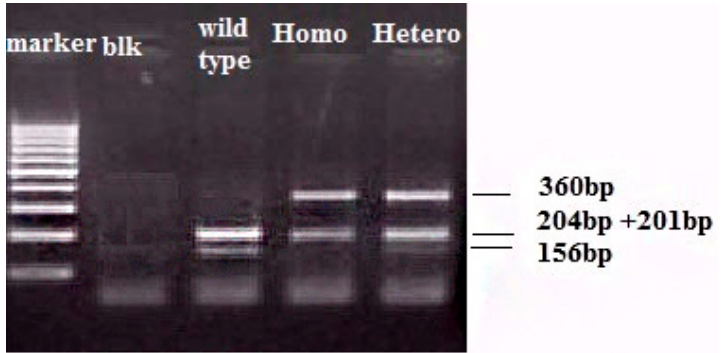
Figure 1. Agarose gel electrophoresis for CD14 C260 T polymorphism genotypes. After digestion of